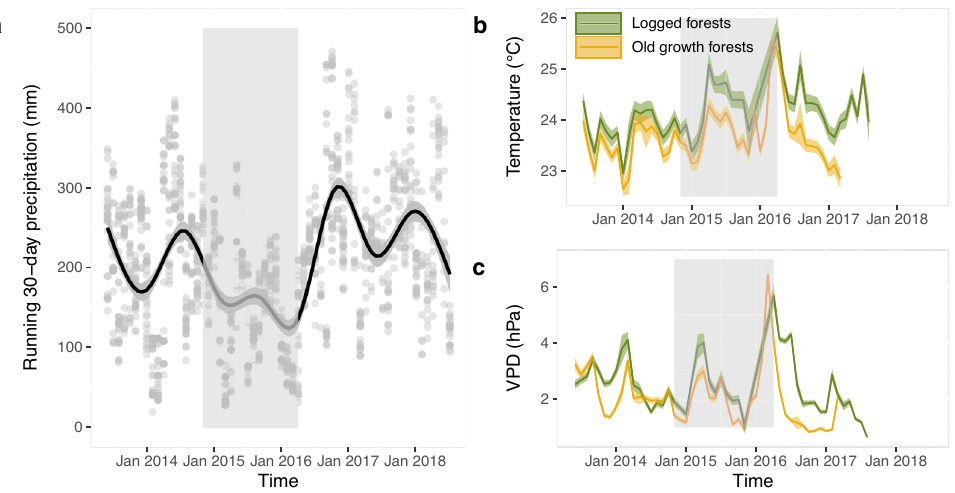
Fig. 1 Reduced precipitation and increased temperatures and vapour pressure de fi cit during the 2015 – 2016 ENSO event. Changes in climatic variables between 2013 and 2018 with the period between both LiDAR surveys (November 2014 – April 2016) which were coincident with the ENSO event highlighted in light grey. a The running 30-day precipitation at the SAFE project in Northern Malaysian Borneo (mm) with 2191 grey points showing daily values in each month and a solid black line representing a cubic smoothing spline with 95% con fi dence intervals as the shaded area. b Mean daily local air temperature (in °C) and c mean daily vapour pressure de fi cit (VPD) computed from 939,388 relative humidity (RH, in %) measurements recorded within 129 permanent forest plots across old-growth and logged forests with shaded areas representing the 95% con fi dence intervals. VPD is the difference between how much moisture the air can hold before becoming saturated and the amount of moisture present in the air.